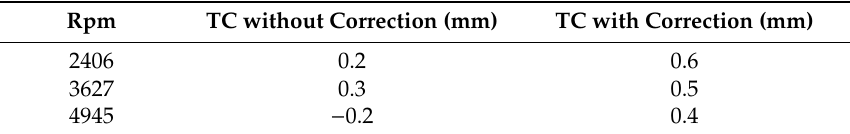
Table 3. Tip clearance values at different rpms for a non-standard blade (blade 54), without and with the correction factor.